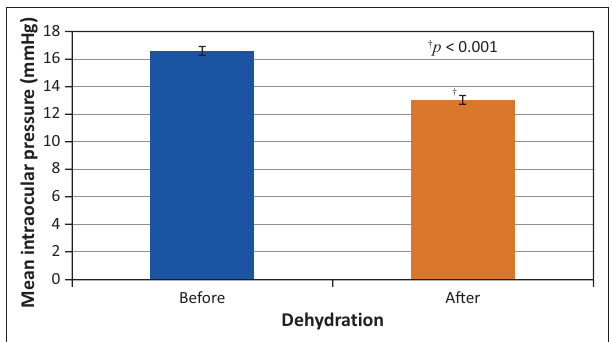
FIGURE 1: Mean intraocular pressure before and after dehydration in the study sample. A paired t -test showed a statistically significant reduction ( p < 0.001) in mean intraocular pressure from the baseline value of 16.68 mmHg ± 0.32 mmHg to 13.08 mmHg ± 0.31 mmHg after dehydration.